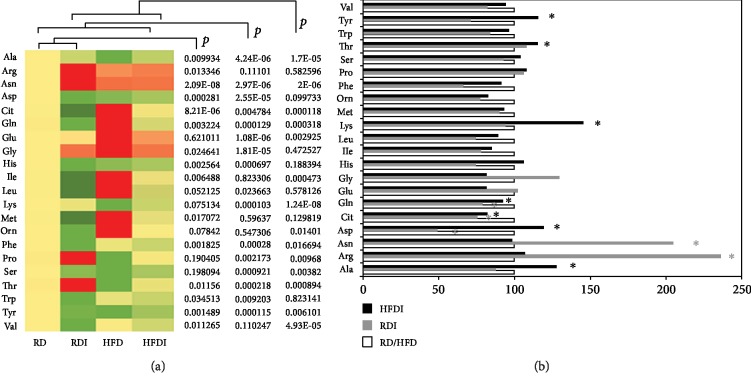
Comparison of amino acid profiling between T. cruzi-infected and uninfected mice fed on different diets at 150 DPI. (a) Heat map representing the serum levels of various amino acids during chronic infection in mice fed on either a RD or a HFD compared to uninfected RD mice at 150 DPI. Each row represents data for a specific metabolite, and each column represents the RD-fed uninfected (RD), RD-fed infected (RDI), HFD-fed uninfected (HFD), or HFD-fed infected (HFDI) mouse group. Different colors correspond to the different intensity level of metabolites (red > the control RD group and green < the control RD group). Statistically significant differences were tested using Student's t-test, and the corrected p values (q-value) are presented next to the heat map. Red, yellow, and green rectangles indicate high, moderate, and low expressions, respectively. (b) The percentage changes in the levels of amino acid metabolites in infected mice compared to the respective diet-fed (RD and HFD) uninfected mice represented by a bar graph (∗significant change).